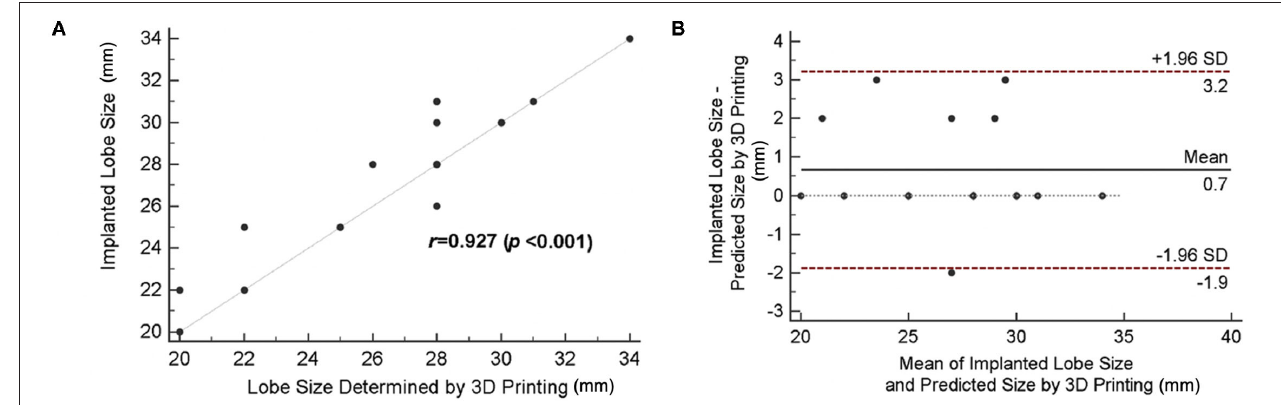
FIGURE 5 | Accuracy of device size prediction based on 3D printing simulation. (A) Correlation between 3D-printed simulation-based predicted size and actually implanted lobe size. (B) The Bland–Altman plot comparing the predicted size by 3D printing simulation and the actual device